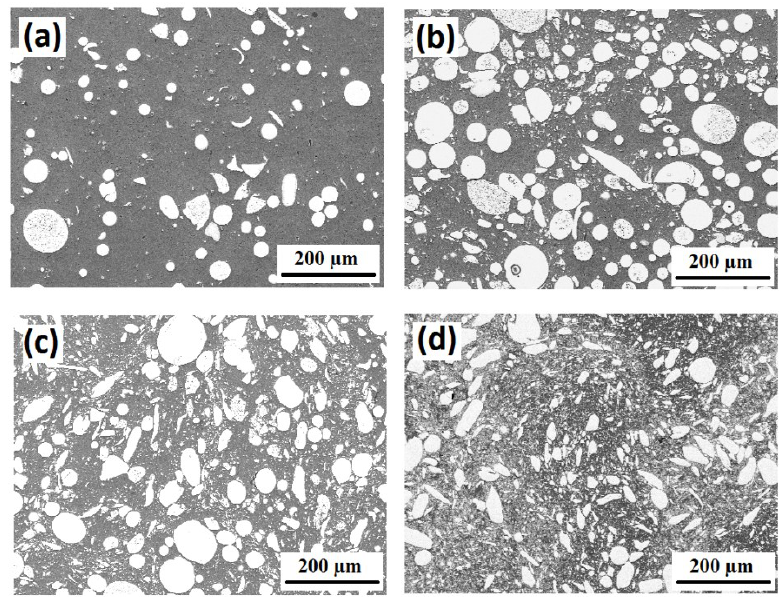
Figure 5. SEM micrographs of the hot pressed and hot extruded composites obtained from ( a ) 1-h, ( b ) 10-h, ( c ) 30-h and ( d ) 50-h milled